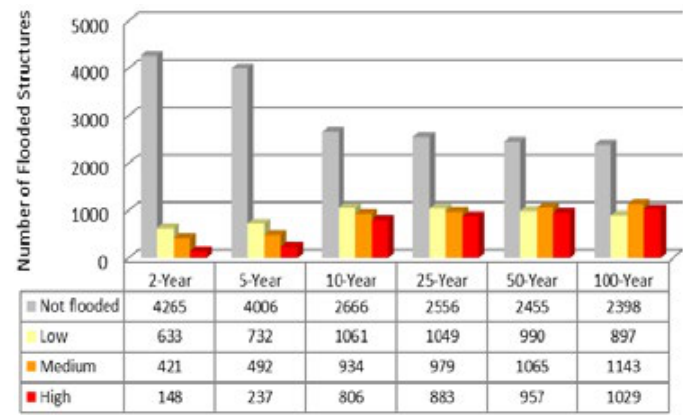
Fig. 8: Flooded structures in Solana watershed for the six flood scenarios at different hazard levels